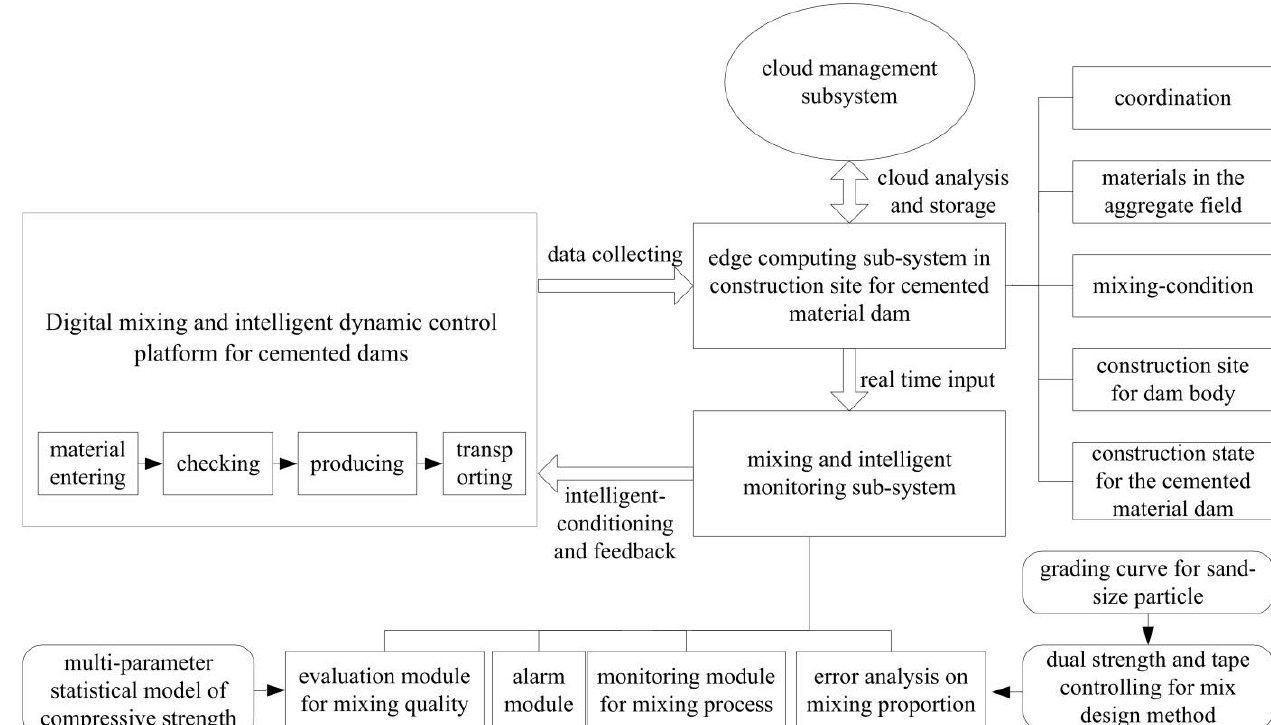
Figure 8. Digital mixing and intelligent dynamic control platform for cemented dams.